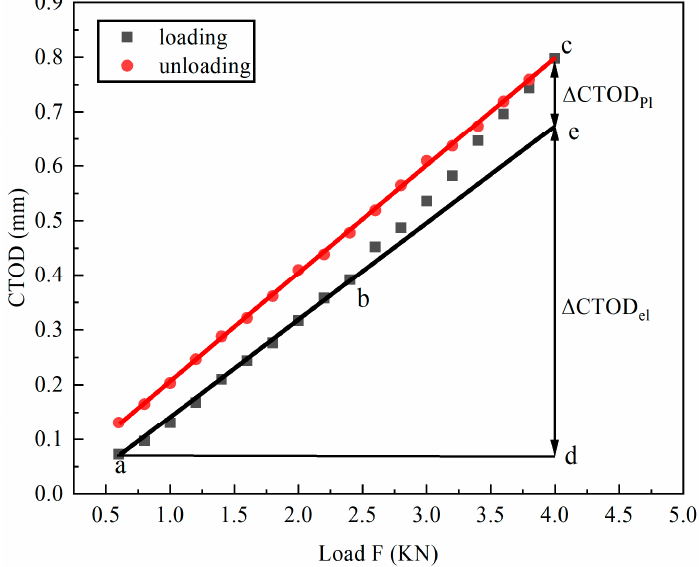
Figure 11. Overload weld specimen a = 14.84 mm elastic CTOD and plastic